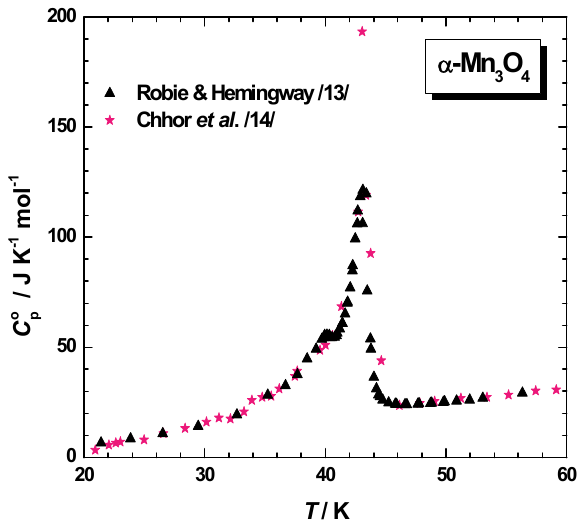
Figure 5. Comparison of low-temperature heat capacities of ˛ -Mn 3 O 4 reported by Robie and Hemingway [13] and Chhor et al.